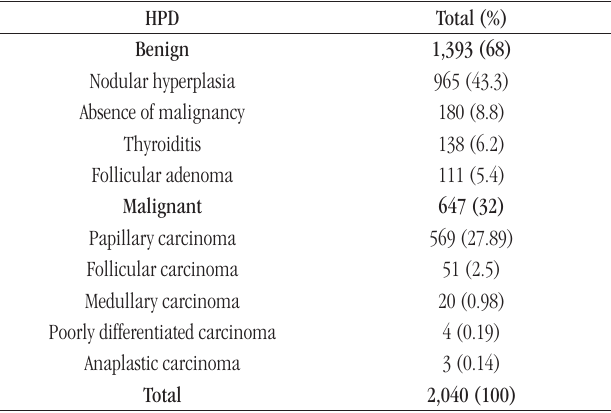
Among the 2,040 IOCs performed in the thyroid gland, HPD ( Table 5 taBLE 5 – Thyroid neoplasms at Inca between January 2001 and